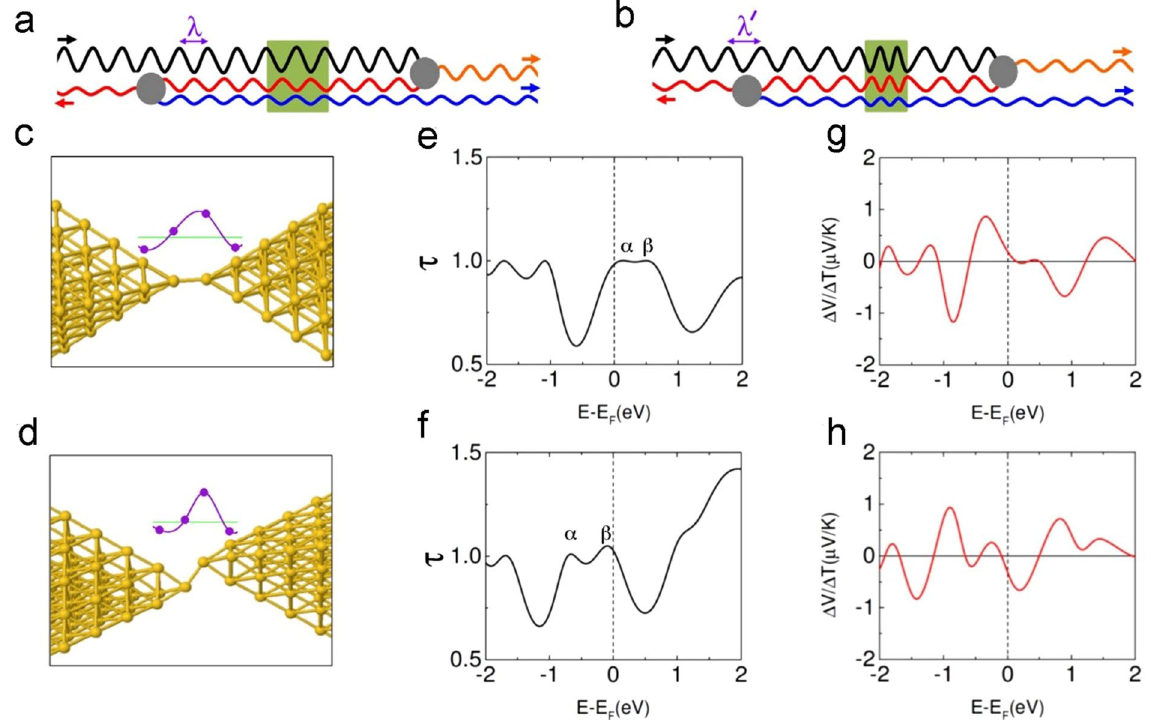
Figure 3. Mechanical manipulation of quantum interference and thermoelectric effect for a weakly strained Au atomic junction. ( a,b ) Simplified picture of the quantum interference in Au atomic junctions. An electron wave enters from the left and passes through the atomic junction (shown in green) once, or three times after scattering from defects shown in grey. The wave accumulates different phase shifts Δϕ = 4 π or 4.5 π as it passes through the unstrained ( a ) or strained ( b ) atomic junction, respectively. In both cases the two partial waves exiting to the right interfere constructively (transmission is maximal) because states with suitably differing energies and de Broglie wavelengths ( λ and λ ’) outside of the junction were chosen. ( c,d ) Model Au geometries near the junction. In ( c ) the distance between the two central Au atoms in the junction is 2.75 Å. It has been reduced to 2.63 Å in ( d ). Insets: Typical calculated wave functions Re( < 6 s| Ψ> ) in the junctions. Δϕ = 2.23 π and 2.36 π for ( c ) and ( d ) respectively. ( e,f ) Calculated Landauer electron transmission probabilities τ ( E ) (ignoring spin) through the structures ( c,d ) vs. electron energy E . Peaks of τ ( E ) are at lower energies in ( f) than ( e ). Conductances are given by G = G 0 τ ( E F ) = 0.985 G 0 and 1.03 G 0 in ( e ) and ( f ), where G 0 = 2 e 2 / h . ( g,h ) Δ V / Δ T defined by Eq. 1 vs. energy E calculated at a mean temperature of 27 K for the structures ( c,d ). At the Fermi level, Δ V = + 2.99 μ V and − 4.95 μ V for Δ T = 16 K for ( g ) and ( h